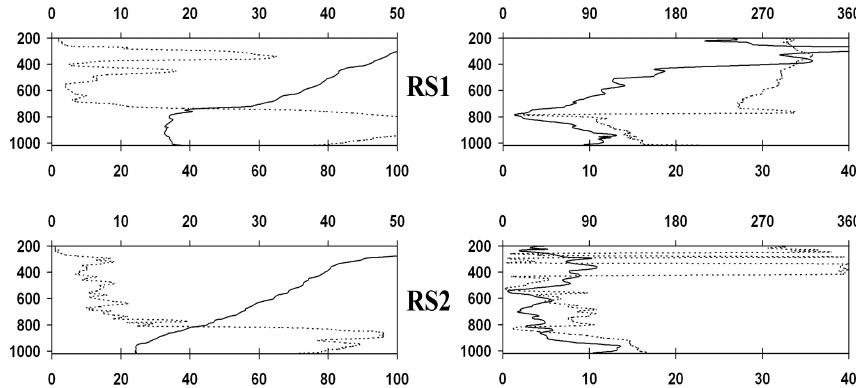
Fig. 10. Same as Fig. 7 but for the rs1 and rs2